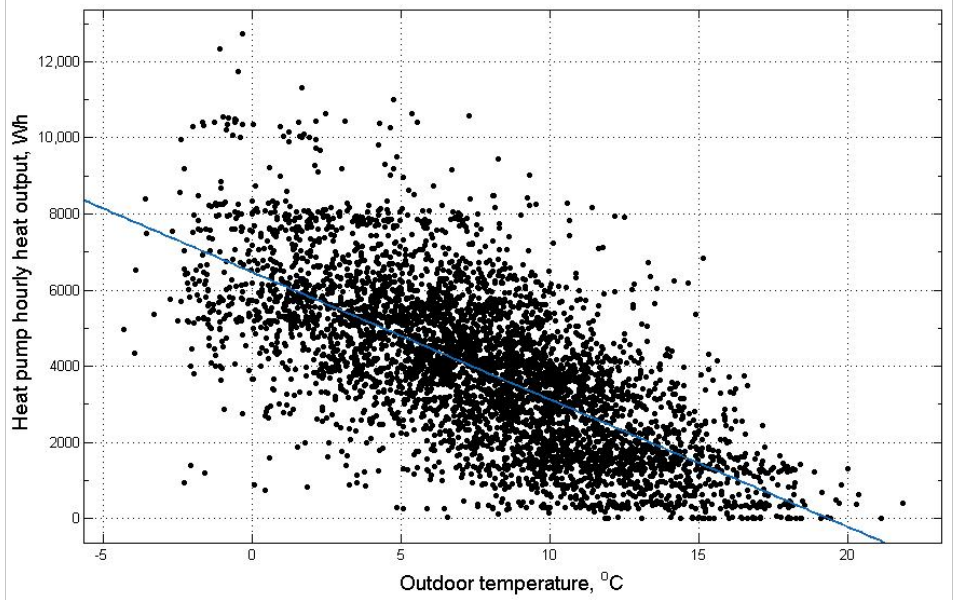
Figure 3. Heat pump hourly heat output versus outdoor temperature for a heat pump operating over a one-year period.